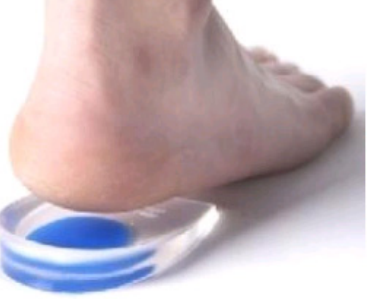
Figure 7. Soft shoe in-sole insert material in the heel for people with calcaneal spur. Foot pain can be minimized by redistributing pressure from the affected area for ex- ample using shoe in-sole [28]. Accurate foot pressure distribution measurements can